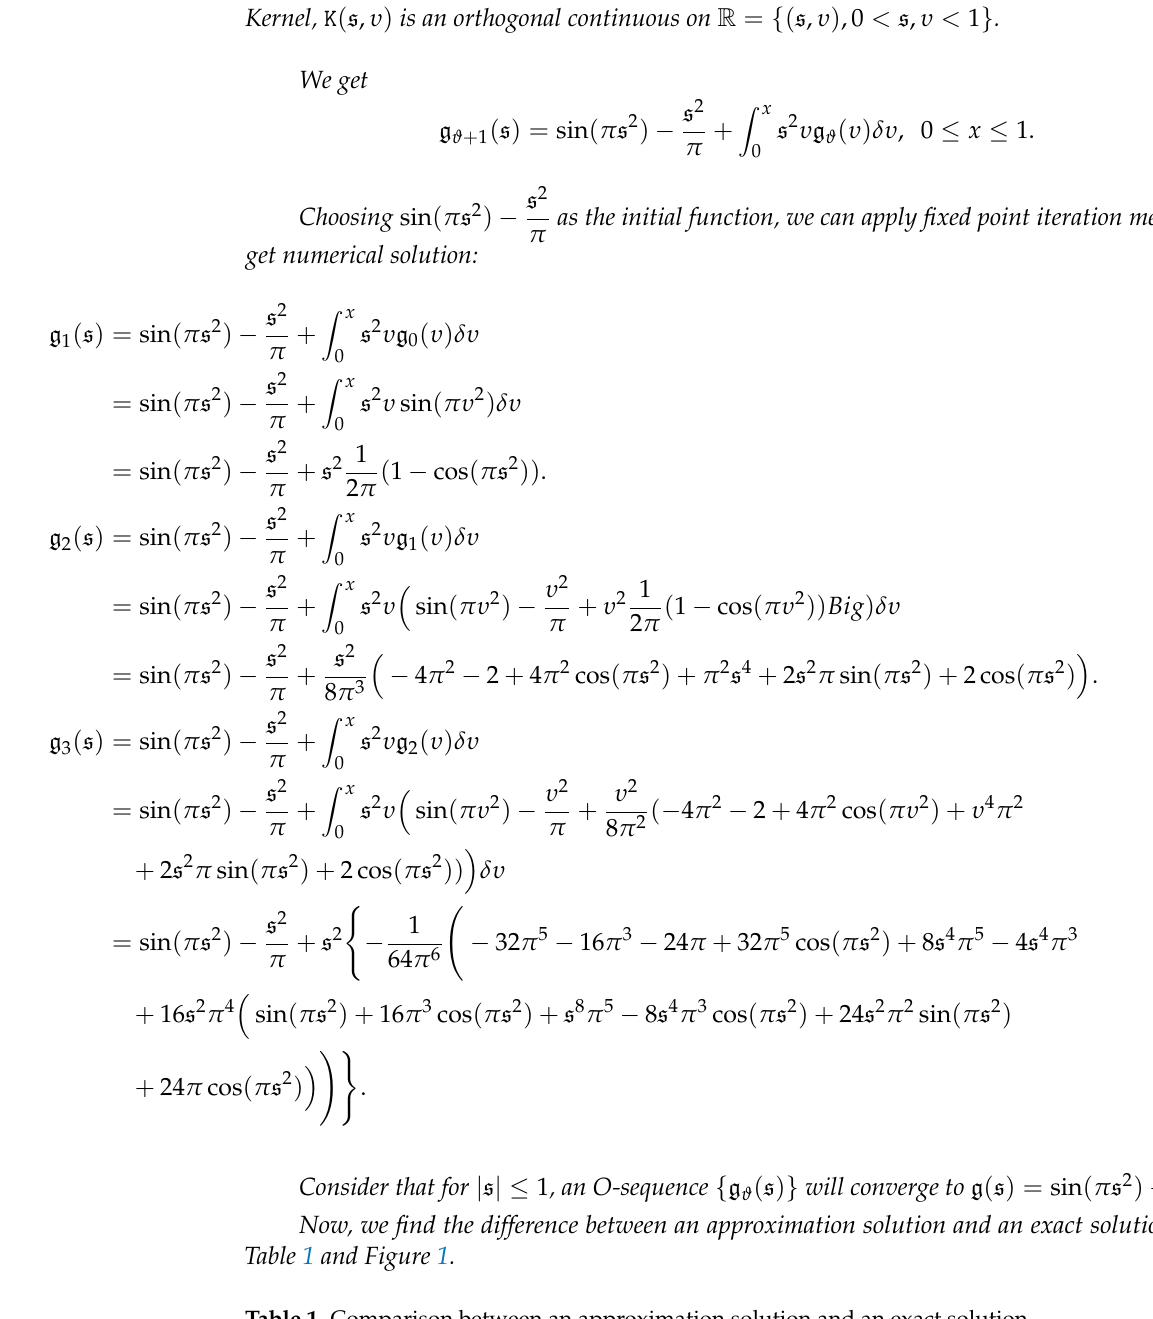
Table 1. Comparison between an approximation solution and an exact